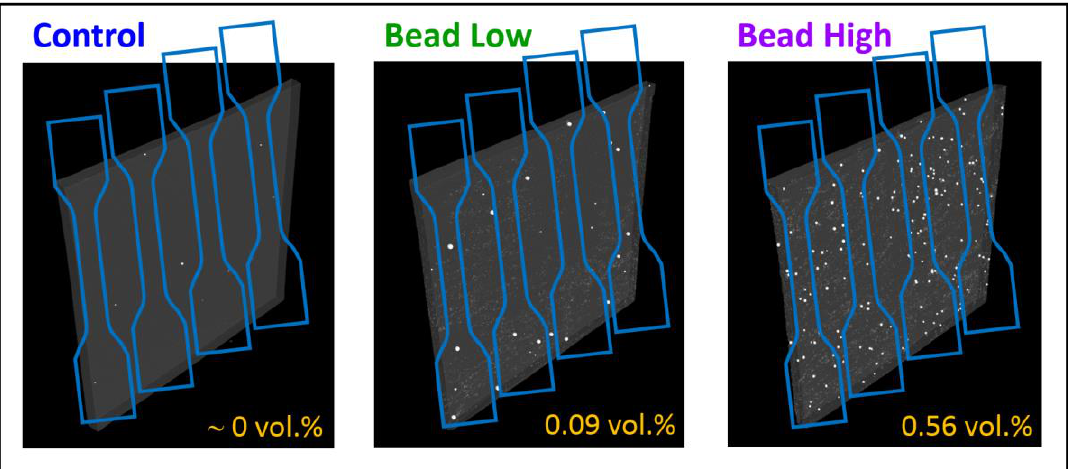
Figure 2. X-ray computed tomography scans for specimens with approximate dimensions of 40 mm × 40 mm × 2 mm. The numbers represent the amount of higher electron density components within each material. Also shown are dimensions of the dumbbell specimens used for tensile testing.